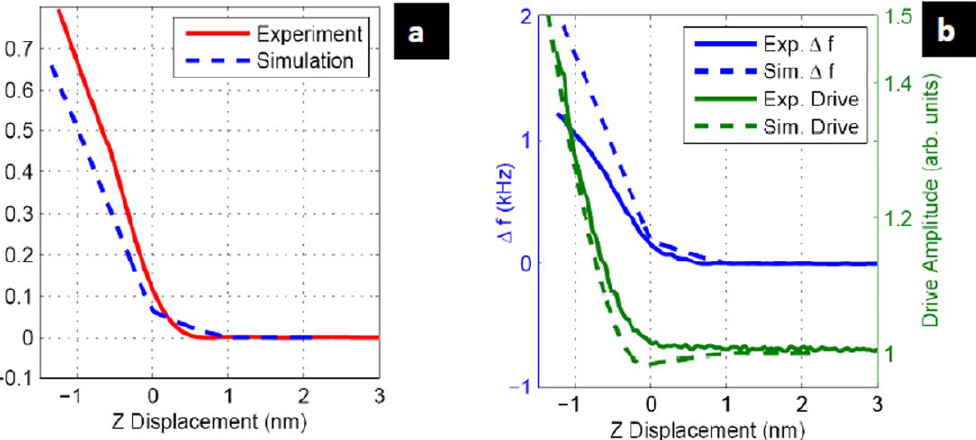
Figure 4. Inliquid FM-AFM basis. (a) Experimental (solid line) and simulated (dashed line) average deflection (mean force) of the cantilever as the tip approaches the sample surface. The horizontal axis is the piezo elongation. (b) Experimental (solid lines) and simulated (dashed lines) frequency shift and drive amplitude as the tip approaches de sample surface. The horizontal axis is the piezo elongation. All the magnitudes in (a) and (b) were acquired simultaneously. Oscillation amplitude 1.2 nm., calibrated spring constant of 0.6